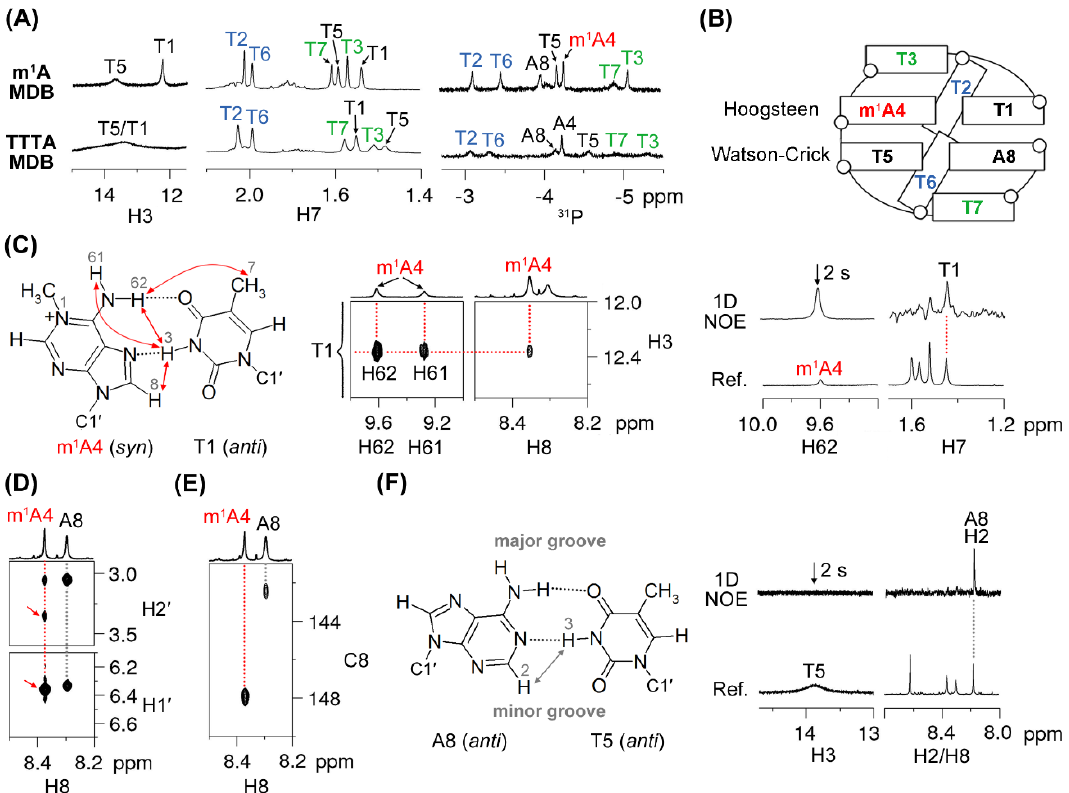
Figure 2. ( A ) A comparison of the H3, H7, and 31 P signals between the m 1 A MDB and TTTA MDB [25]. ( B ) Schematic of the m 1 A MDB. ( C ) The T1·m 1 A4 Hoogsteen base pair is supported by NOEs of T1 H3-m 1 A4 H61/H62/H8 and 1D NOE of T1 H7-m 1 A4 H62. The syn base orientation of m 1 A4 is supported by ( D ) much stronger m 1 A4 H8-H1′ NOE than m 1 A4 H8-H2′ NOE (indicated by red arrows) and ( E ) downfield shifted m 1 A4 C8 signal in the 1 H- 13 C HSQC spectrum. ( F ) The T5-A8 Watson–Crick base pair is supported by the 1D NOE of T5 H3-A8 H2. Spectra in ( A , D , E ) were acquired at 5 °C, and those in ( C , F ) were acquired at 0 °C. A mixing time of 50 and 450 ms, respectively, was used for the 2D NOESY spectra shown in ( C , D ), respectively. Table 1. Thermodynamic parameters a of the m 1 A MDB and TTTA